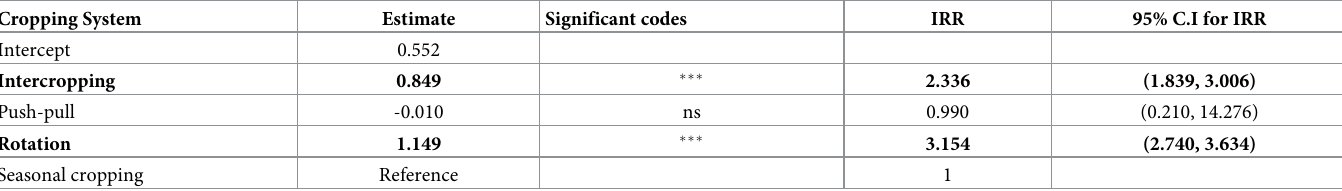
Table 2. Regression parameter estimates and incident rate ratios (IRR) estimated from the negative binomial model on trap counts for the cropping system factor adjusted for crop phenology with ‘Seasonal cropping’ used as a reference level ϯ . Cropping